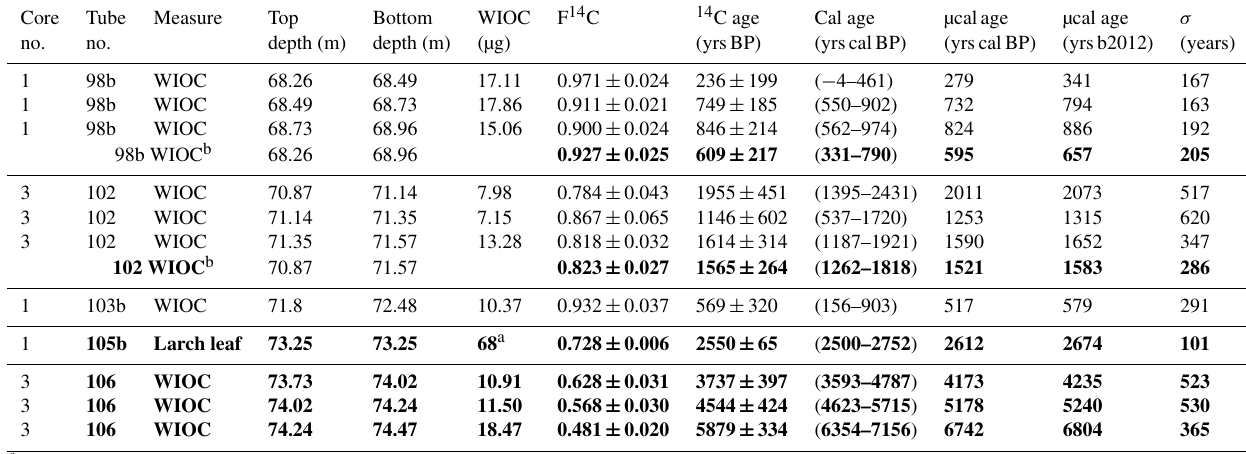
Table 2. 14 C analyses of the particle organic fraction (WIOC) obtained from the four sections (tubes) of the Mt. Ortles ice cores no. 1 and no. 3. Except for Sect. 103b, the samples were analysed in three subsamples (top, middle, bottom). 14 C determination in Sect. 105b (core no. 1) refers to a larch leaf that was found in the ice. Samples reported in bold are those also included in Table 3. Note the notation used for calibrated ages in